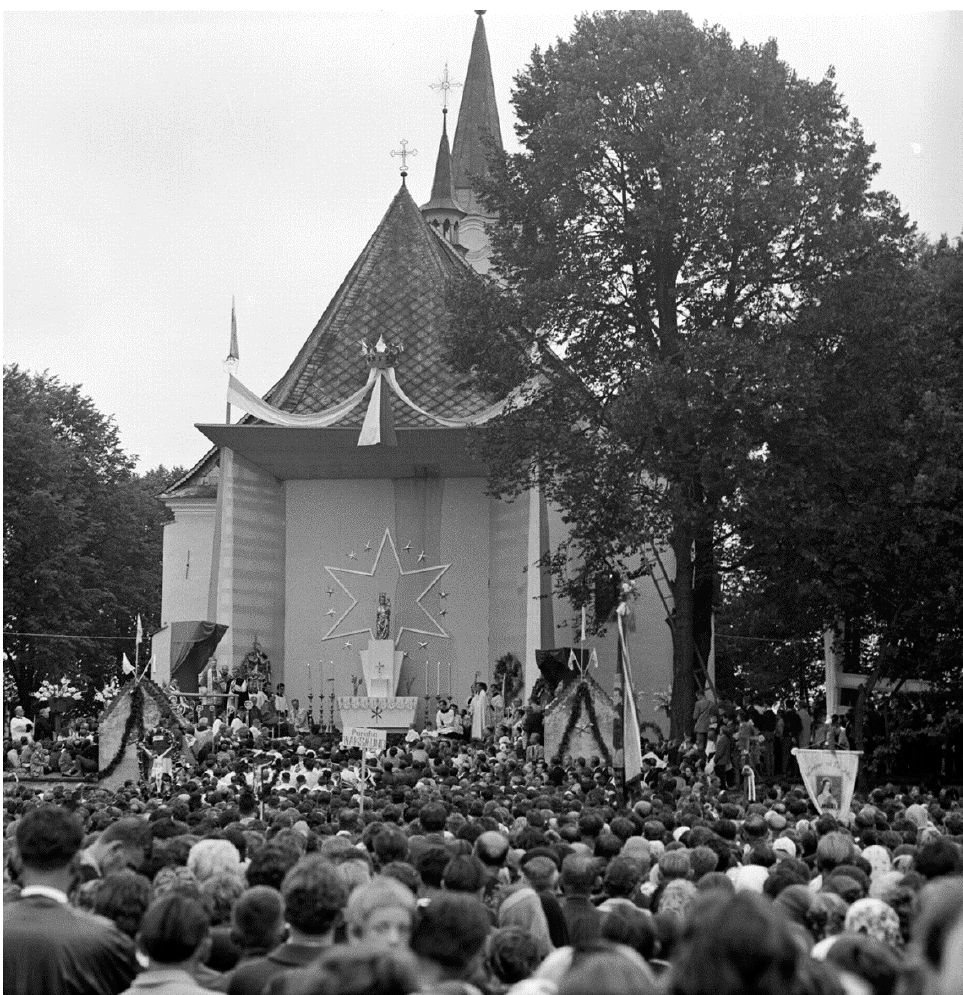
Figure 9. Celebrations of the coronation of the statue of Our Lady of Lud ź mierz—Queen of Podhale in Lud ź mierz (15 August 1963) (photo: Archives of the Shrine of Our Lady of Lud ź mierz—Queen of Podhale in Lud ź mierz).